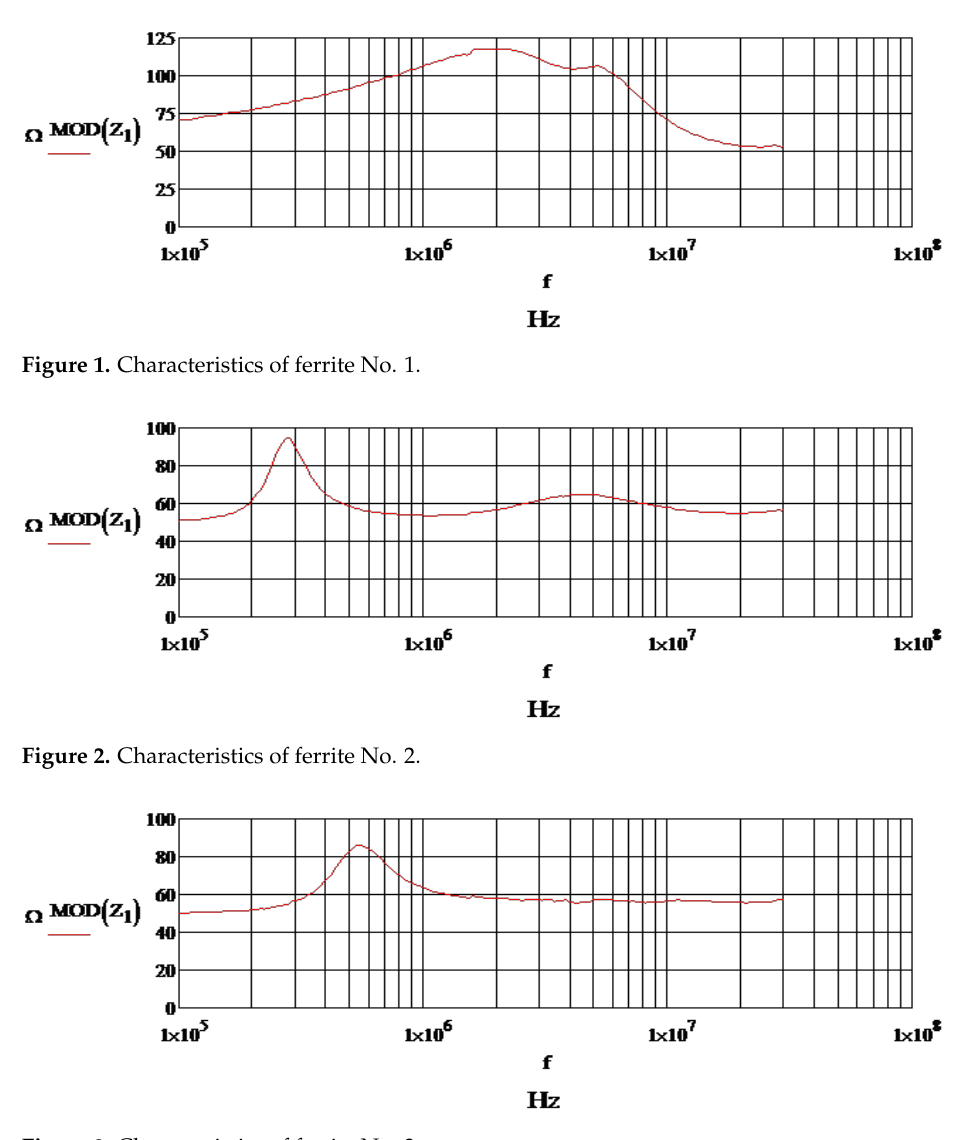
Figure 3. Characteristics of ferrite No.